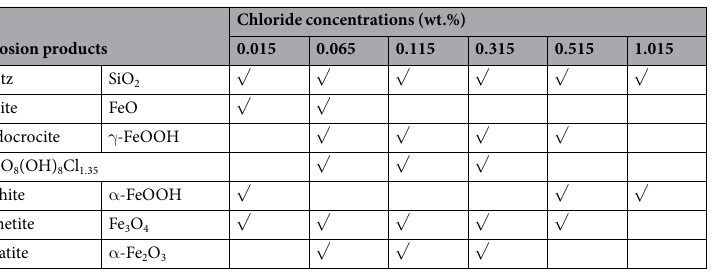
√ √ Table 3. Main compositions of corrosion products of ductile iron coupons exposed to soils of different chloride concentrations after 12